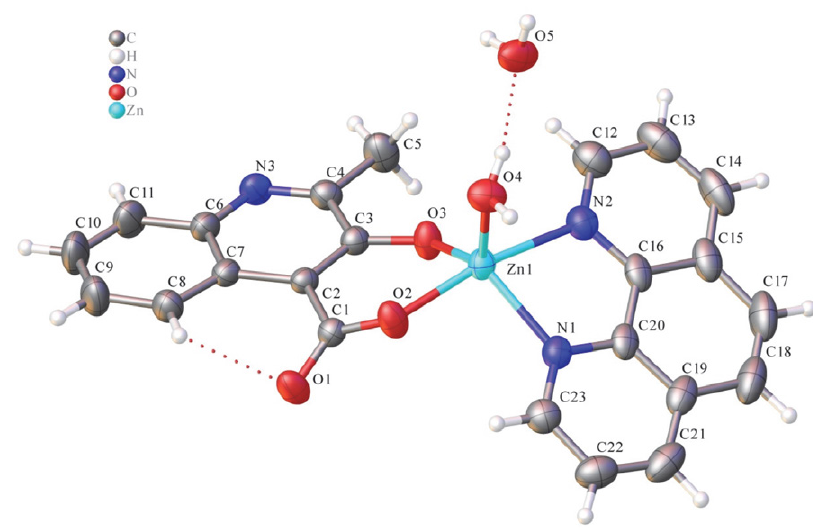
Fig. 1. The molecular structure of the title complex